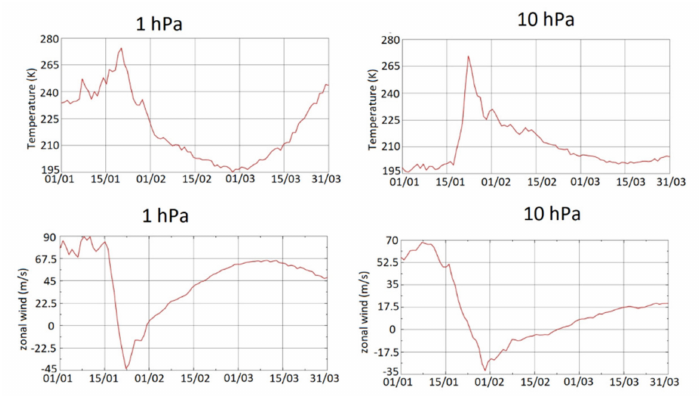
Figure 1. Polar temperature at 90 ◦ N for 1 and 10 hPa ( upper panels ) and zonal mean of zonal wind at 60 ◦ N ( bottom panels ) for 1 and 10 hPa during 1 January 2009–31 March 2009.